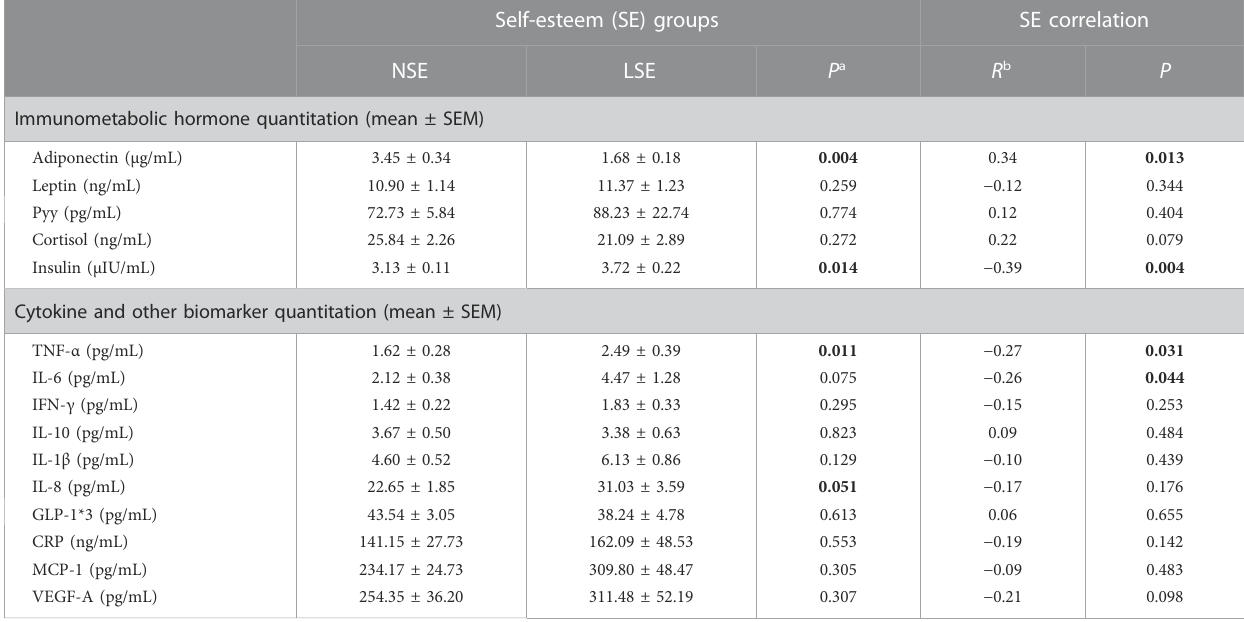
TABLE 2 Intergroup comparison and correlational analyses of immunometabolic biomarker concentrations by